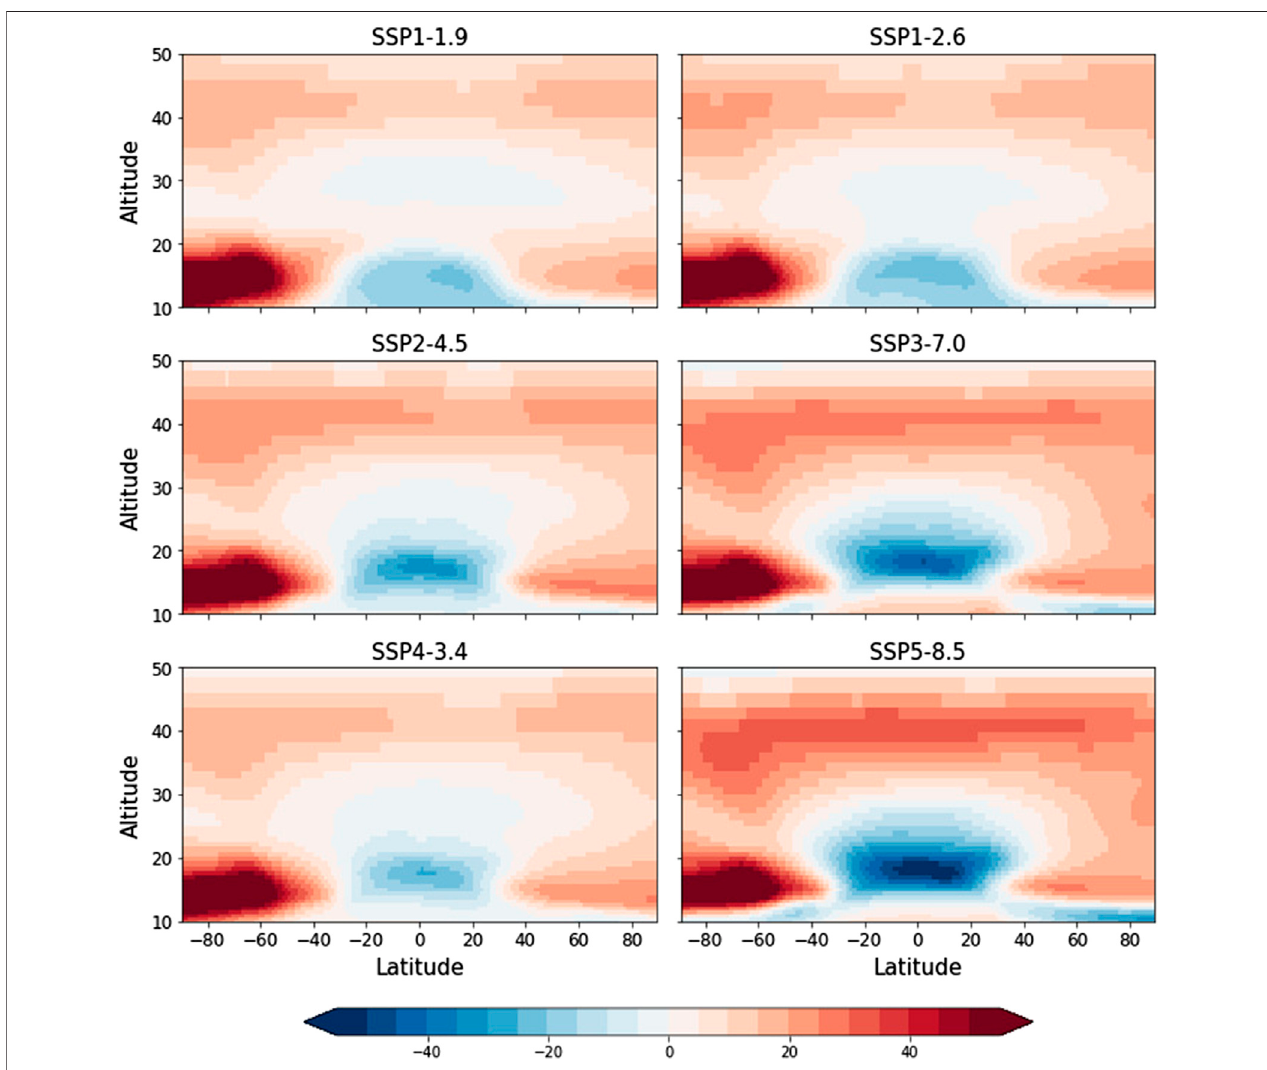
FIGURE 3 | Percentage zonal mean ozone difference between the present day (2000 – 2014 averaged) and end of century (2086 – 2100 averaged) modeled by UKESM1 under the different Shared Socioeconomic Pathways.